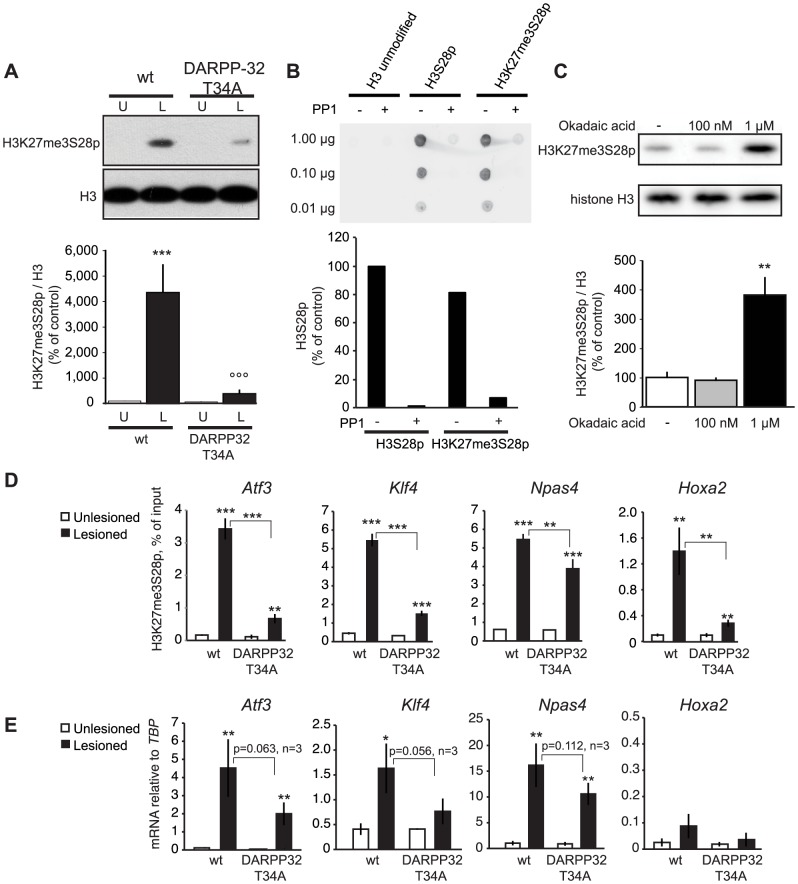
L-DOPA induced H3K27me3S28 phosphorylation and gene activation are dependent on a functional PP1 interaction site on DARPP-32.A) H3K27me3S28p was attenuated in T34A mutant mice following chronic administration of L-DOPA (lesioned x genotype interaction: F(1,28) = 12.21, p = 0.002). *** p<0.001 vs unlesioned wt hemisphere, °°° p<0.001 vs lesioned wt hemisphere. N = 8 per condition. Data are means ±S.E.M.). B) PP1 efficiently dephosphorylates H3K27me3S28p in vitro. H3 non-modified, H3S28p or H3K27me3S28p modified peptides were incubated in the presence or absence of PP1. The peptide dot-blots were developed using an anti-H3S28p antibody. C) Striatal tissue slice culture experiment showing that H3K27me3S28p was induced after 50 min incubation with 1 µM, but not 100 nM, okadaic acid (effect of treatment: F(2,8) = 19.64, p = 0.0008). ** p<0.01 vs vehicle and 100 nM okadaic acid (n = 3–4). Data are means ±S.E.M. D) Levels of H3K27me3S28p on regulatory regions of Atf3, Klf4, Npas4 and Hoxa2 were attenuated in striata from DARPP-32 T34A mutant mice compared to wt mice. ChIP-qPCR for H3K27me3S28p from unlesioned and lesioned striata from DARPP-32 T34A mutant and wt mice (acute L-DOPA). Data are means +/−S.E.M. of triplicate qPCR reactions. The signal from the lesioned striata is compared to the respective signal in the unlesioned striata, and the signal in the DARPP-32 T34A chromatin is compared to the respective signal in wt chromatin; * p<0.05, ** p<0.01, *** p<0.001. E) Attenuated activation of genes in DARPP-32 T34A mice after L-DOPA injection. RT-qPCR using primers for Atf3, Klf4, Npas4, Hoxa2 and Tbp (for normalization) showing mRNA levels of respective gene in unlesioned and lesioned striata of acute L-DOPA injected DARPP-32 T34A mutant or wt mice. N = 3 mice per condition, unlesioned and lesioned striata respectively. Data are means ±S.E.M of biological triplicates. * p<0.05, ** p<0.01, *** p<0.001.